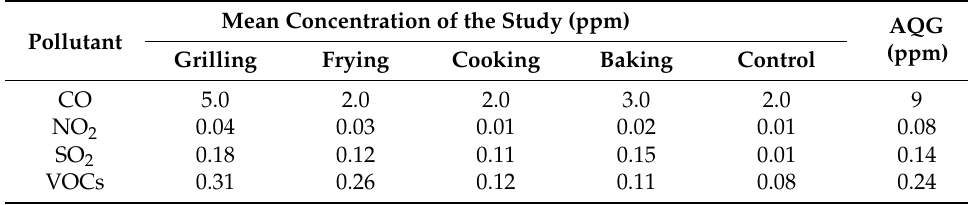
(ppm) Grilling Frying Cooking Baking